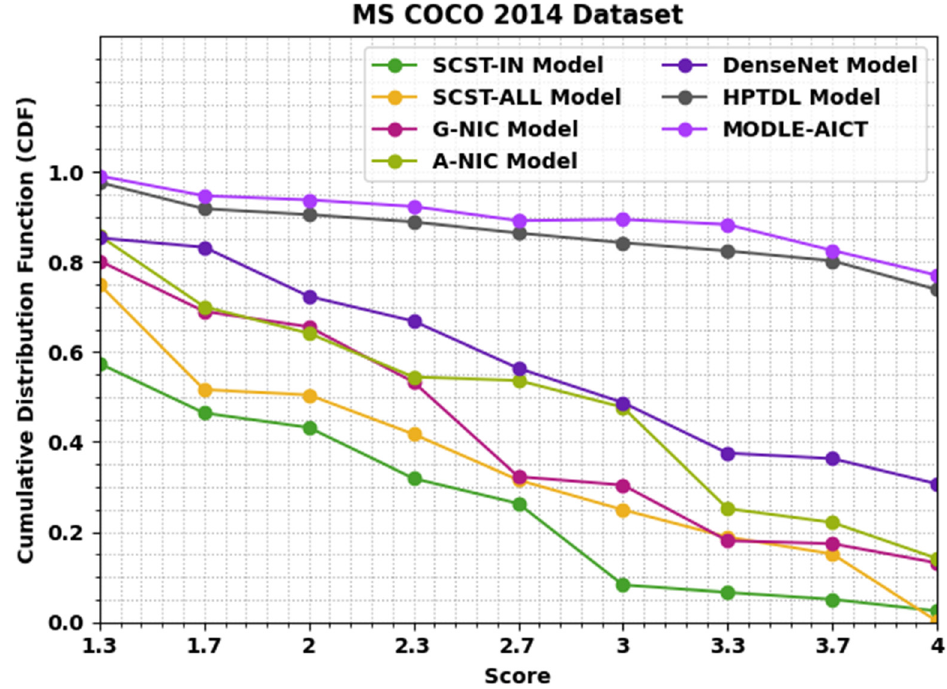
Figure 10. CDF analysis of MODLE-AICT technique with existing approaches on MS-COCO 2014 dataset.